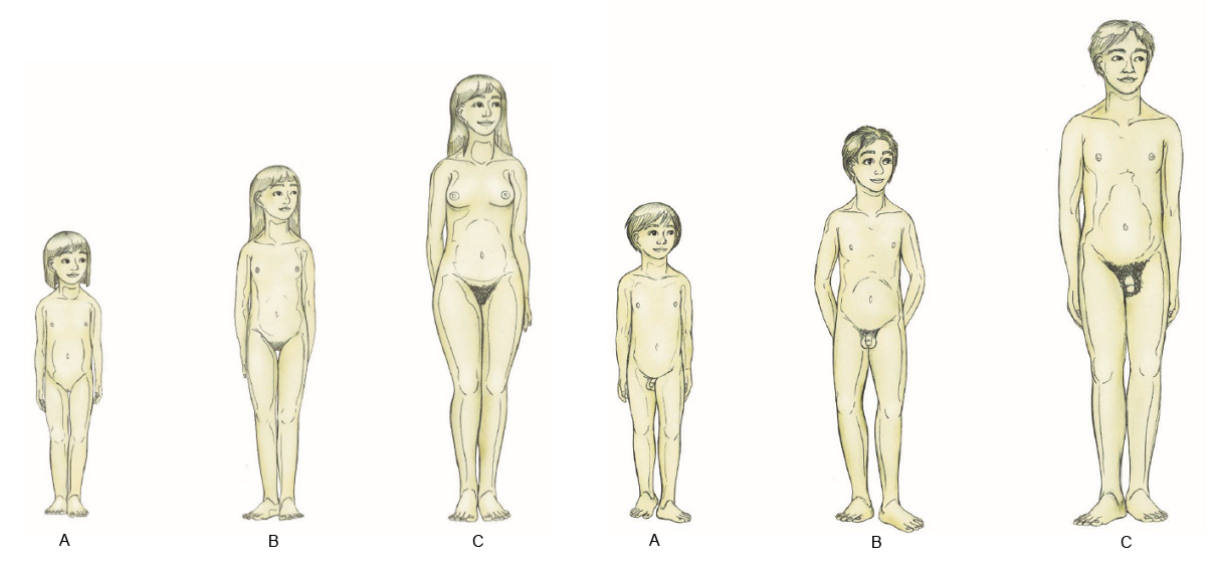
Figure 1. Developmental age categories according to the Tanner stages. A. Tanner stage 1, prepubescent body scheme; B. Tanner stages 2 and 3, early pubescent body scheme; C. Tanner stages 4 and 5, adult body